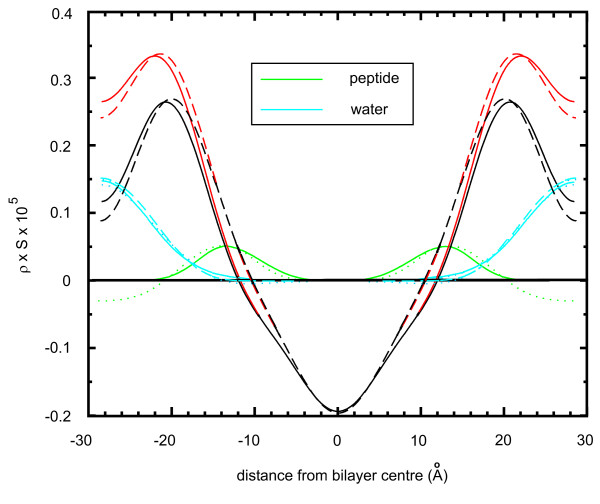
Intramembrane positioning of Aβ(1–42) oligomers, and the distribution of membrane water. The peptide was localised (dotted green line) by subtracting profiles obtained in 8.06 mol% D2O in the presence and absence of the peptide (dashed and solid black lines, respectively). The difference profile was fitted to 2 Gaussian distributions (solid green lines), as described for Fig. 3. The water difference profiles (dotted blue lines) were constructed by subtracting profiles obtained in 8.06 mol% D2O in the presence and absence of peptide, from profiles of the same samples in 20 mol% D2O (dashed and solid red lines, respectively). The water distributions are fitted to single Gaussians (dashed and solid blue lines, with maxima at the edges of the profiles). Note the substantial overlap in the presence and absence of peptide.